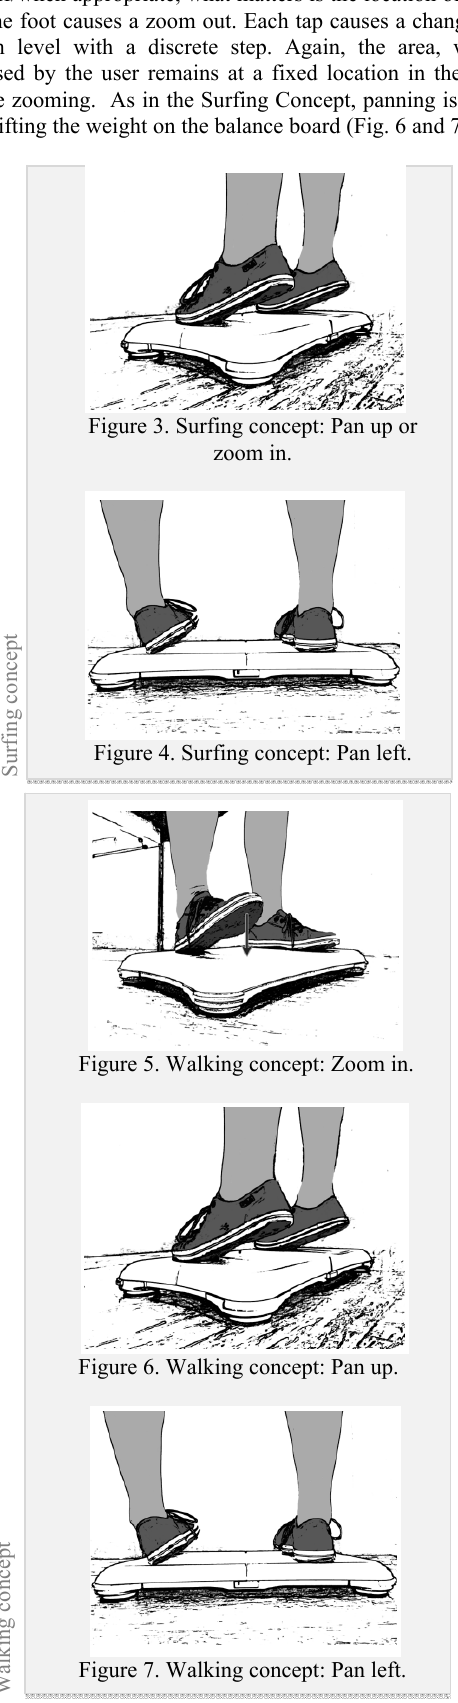
Figure 7. Walking concept: Pan